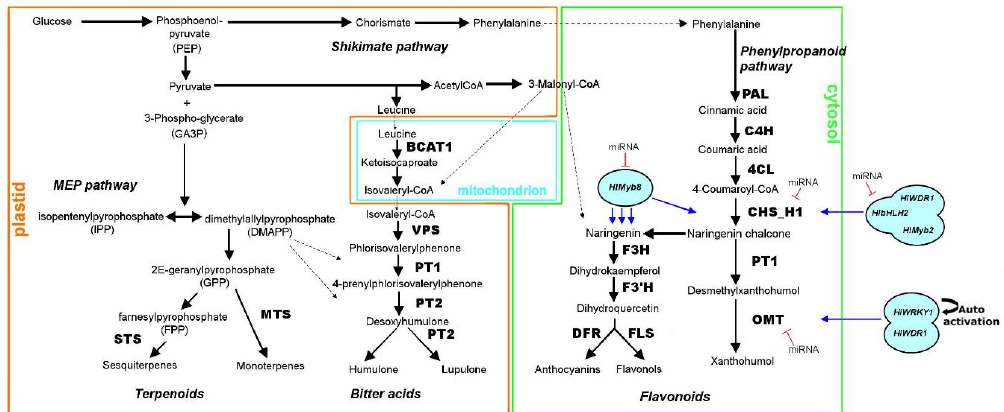
Figure 2. Schematic overview of the biosynthetic pathways (terpenoids, bitter acid, phenylpropanoids and flavonoid) in the hop. The methyl- d -erythritol 4-phosphate (MEP) pathway leading to DMAPP biosynthesis contributes to the bitter acid and terpenoids biosynthesis. Bitter acids are formed from acyl-CoA precursors derived from branched-chain amino acid (BCAA) degradation and MEP pathway. The prenylated chalcones (xanthohumol) biosynthesized via shikimate pathway. The main intermediate compounds are shown with the abbreviation of respective enzymatic steps. Enzyme